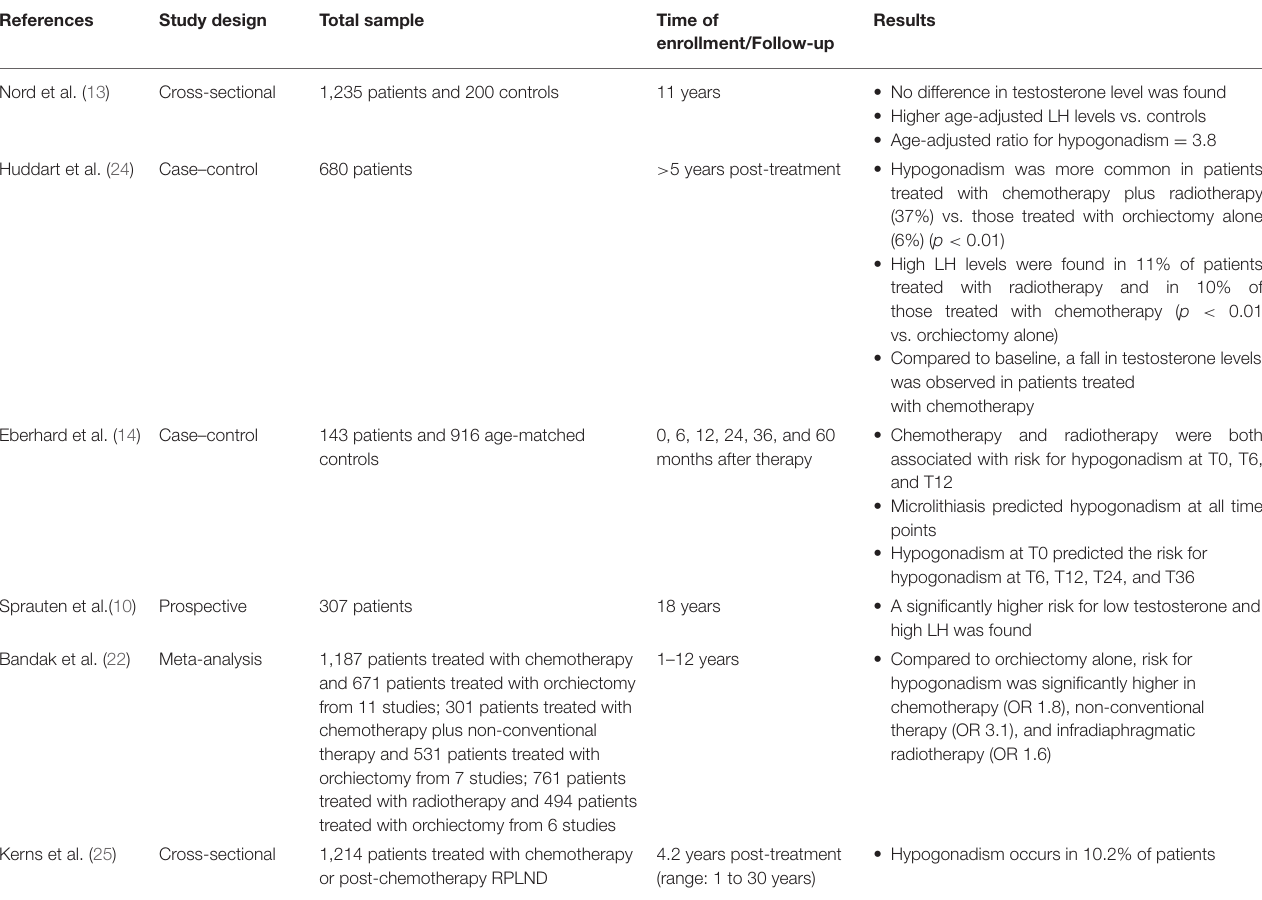
TABLE 2 | Summary of available data from studies on hypogonadism in testicular cancer